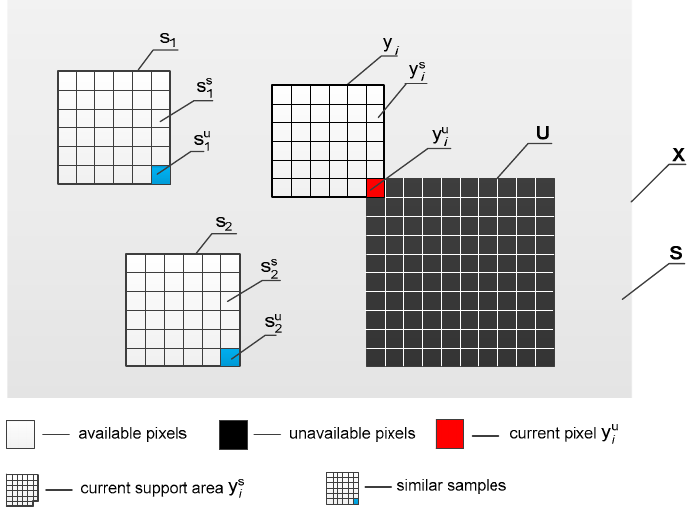
Figure 1. Structure of the corrupted image. Each square stands for one pixel. The black pixels are unavailable ones. The white pixels are correctly received ones. The pixel being predicted is marked in red, and the pixels marked blue are the pixels corresponding to the current pixel y u similar